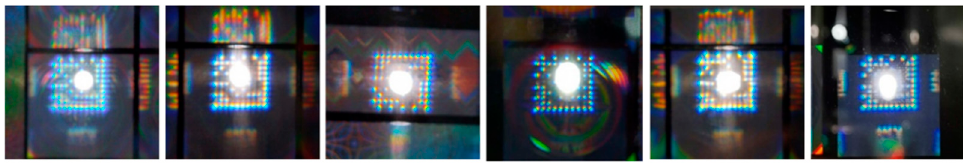
Figure 7. Hidden coded optical mark (exposure fitting).